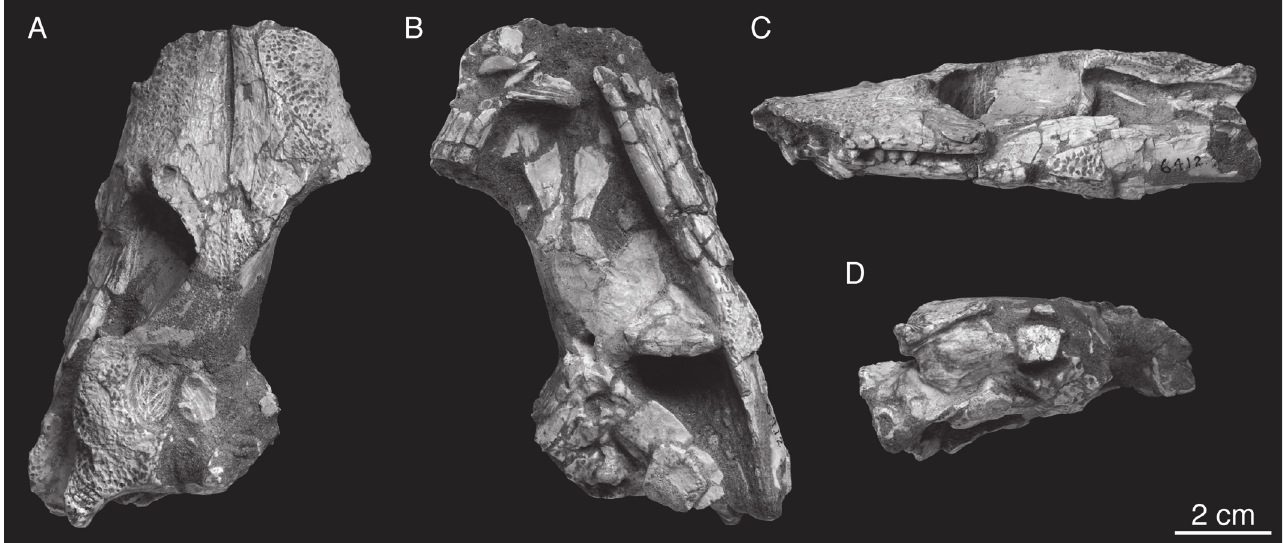
Fig 2. AMNH FARB 6412 (holotype), Shamosuchus djadochtaensis , Djadokhta Fm., Campanian, Mongolia. Photographs in A , dorsal, B , ventral, C , left lateral, D , occipital